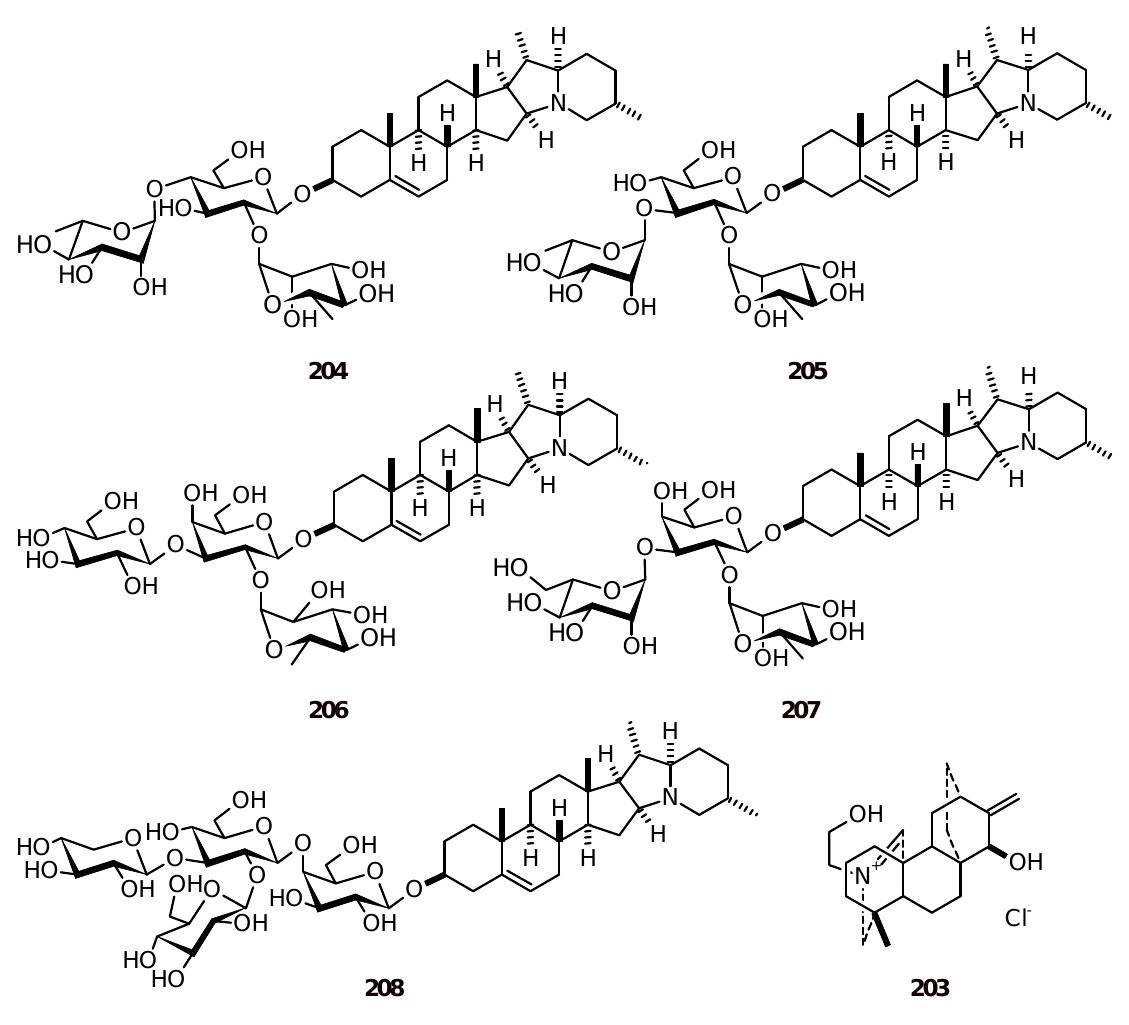
Figure 22. Structures of alkaloids 203 - 208